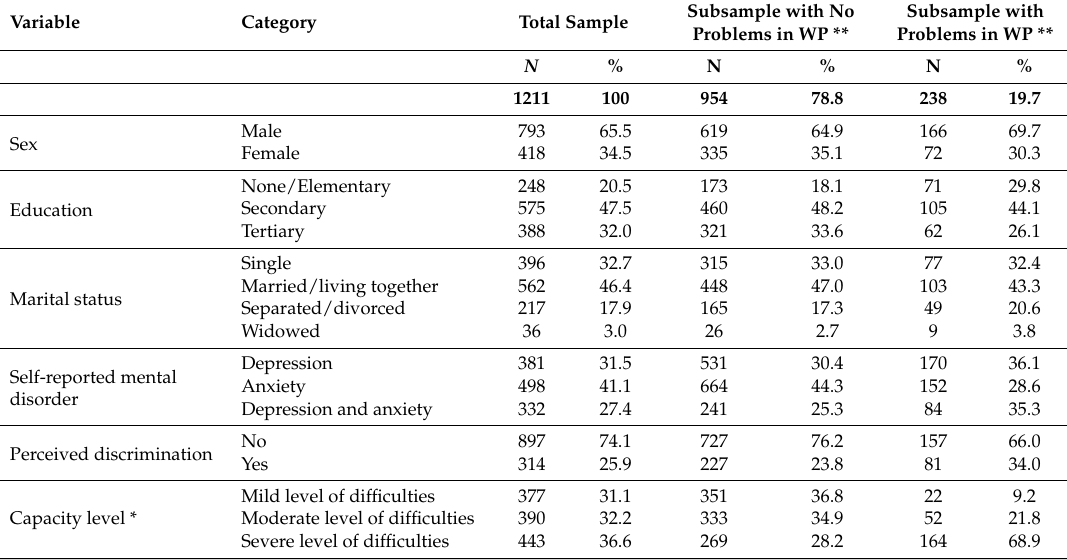
Table 1. Characteristics of workers with anxiety or depression in the total sample and in the subgroups with and without problems in work performance (WP).